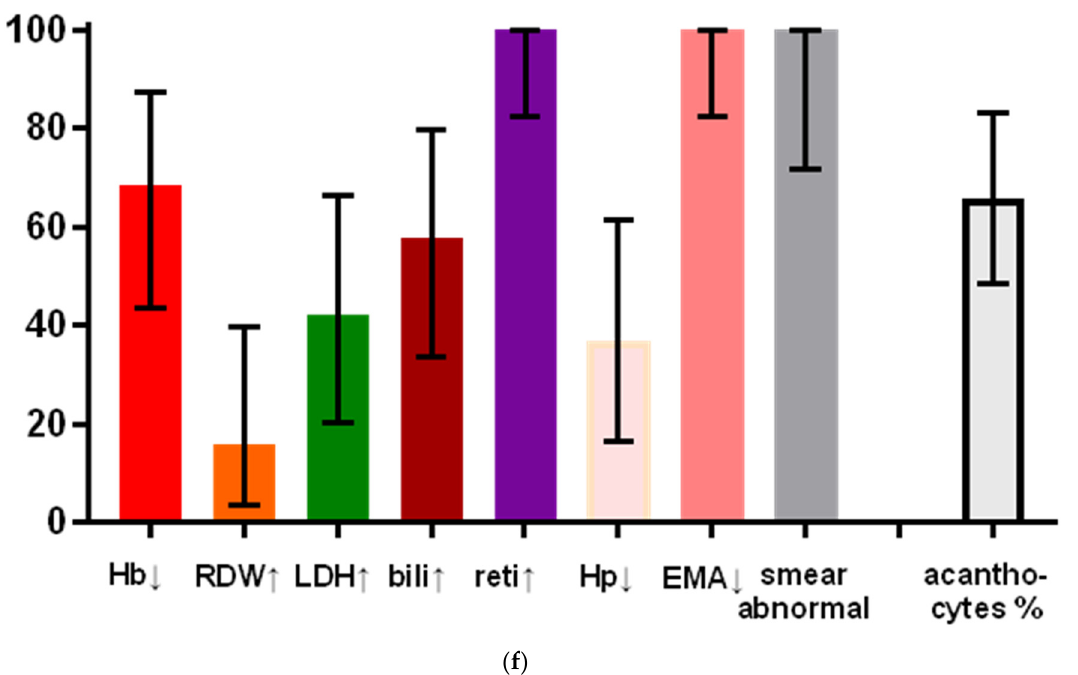
Figure 1. Development of peripheral blood changes after the start of alectinib in ALK + NSCLC. ( a ) Peripheral blood film of patient 8 (Table 1) at 67× magnification showing normal red cell morphology before alectinib start. ( b ) Peripheral blood film two weeks after alectinib start at 67× magnification showing abnormal red cell morphology with anisocytosis, a predominance of acanthocytes, as well as occasional echinocytes, spherocytes, and rare fragmentocytes (Table 1). ( c ) EMA binding assay of the same patient before therapy with alectinib showing a 10% decrease in EMA fluorescence (reference range <20%). ( d ) In the same patient, six weeks after alectinib start, EMA fluorescence is reduced by 58%. ( e ) Changes in hemoglobin (Hb, in g/dl, n = 16), red-cell distribution width (RDW, %, n = 17), serum lactate dehydrogenase (LDH, in U/mL/10, n = 16), total serum bilirubin (bili, in mg/dl, n = 11), blood reticulocytes (reti, %, n = 18), as well as levels of serum haptoglobin (Hp, in g/l, n = 19) and after start of alectinib in our patients. Statistical comparisons were performed with a paired t-test for parameters with available data before and after alectinib start (Hb, RDW, LDH, bilirubin) or using a t-test comparison vs. the upper or lower limit of the normal range for other parameters (5–15% for reticulocytes, and 0.3–2.0 g/l for haptoglobin). Box plots indicate mean values with their standard errors (from left to right: 13.8 g/dl vs. 12.0 g/dl, 13.4% vs. 16.8%, 136 U/l vs.234 U/l, 0.45 mg/dl vs.1.26 mg/dl, 43% with p < 0.0001 compared to the normal range, 0.93 g/l within the normal range of 0.3–2.0 g/l); ns: not statistically significant. ( f ) The percentage of patients with abnormal values for each of the parameters analyzed in this study, according to Table 1. Bars indicate percentages with 95% confidence intervals: 68.4% [43.5–87.4] for reduced serum hemoglobin, 15.8% [3.4–39.6] for increased RDW, 42.1% [20.2–66.5] for increased serum LDH, 57.9% [33.5–79.8] for increased serum bilirubin, 100% [82.4–100] for increased blood reticulocytes, 36.8% [16.3–61.6] for reduced serum haptoglobin, 100% [82.4–100] for reduced EMA binding, and 100% [71.5–100] for the presence of abnormalities in the blood smear, while the mean percentage of acanthocytes in the peripheral blood smear was 65.8% [48.6–83.1].